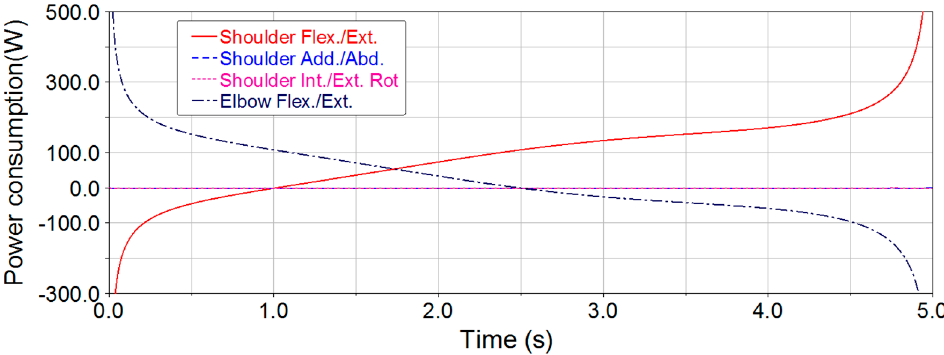
Figure 15. Joint power consumption curves of raising up for the 5 ‐ DOF exoskeleton.